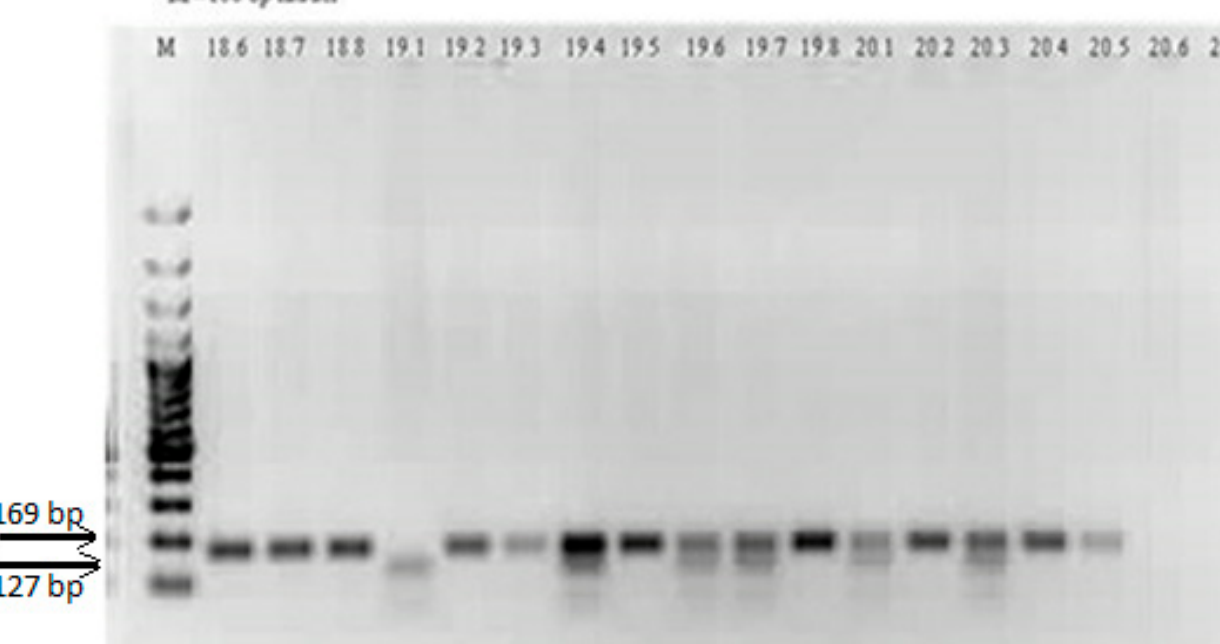
Figure 1. Agarose gel electrophoresis of the restriction products obtained in PCR-RFLP genotyping analysis for PON1 L55M (163T > A, rs 854560) SNP.